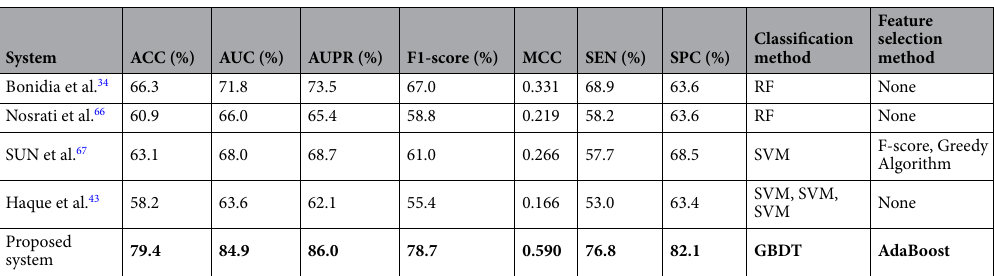
Table 10. The performance comparison, classification methods, and feature selection methods used in state- of-art systems compared with the proposed system based on the protein dataset. Significant values are in bold.